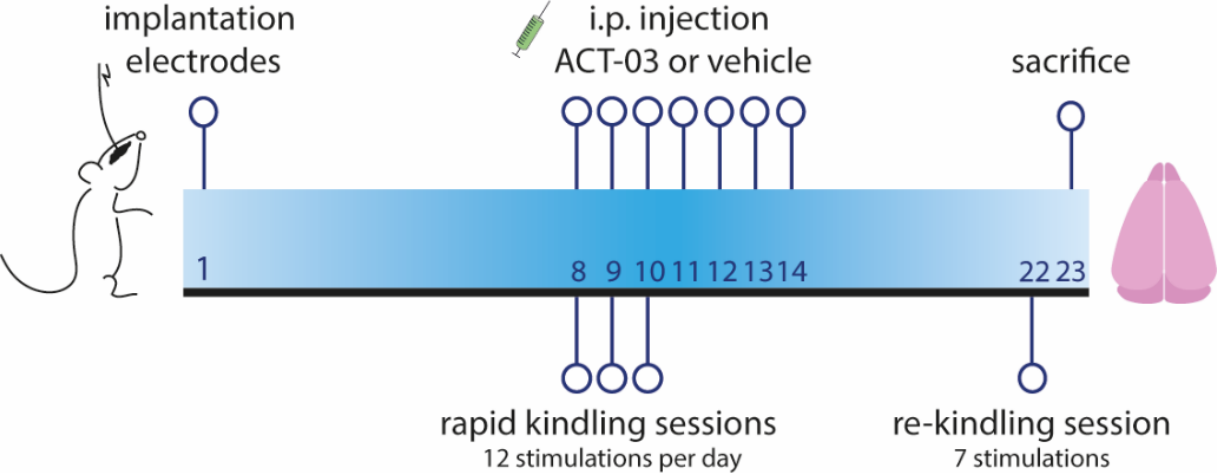
Figure 1. Timeline of rapid kindling rat experiment. One week after implantation of stimulation and EEG electrodes in the angular bundle and hippocampus respectively, animals were given 12 kin-